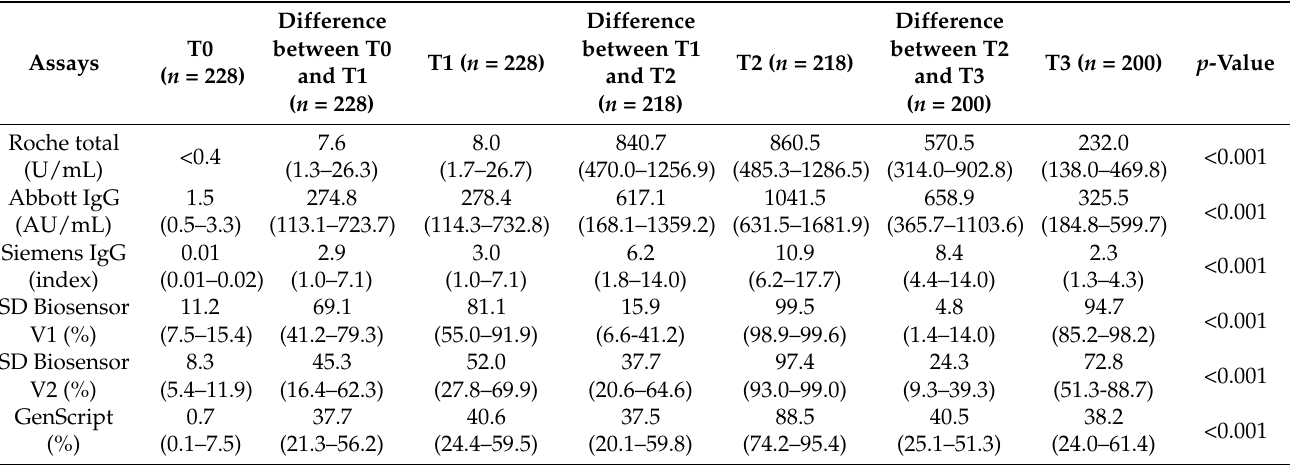
Table 2. Quantitative serological responses after a ChAdOx1 nCoV-19 vaccination according to the sampling time after